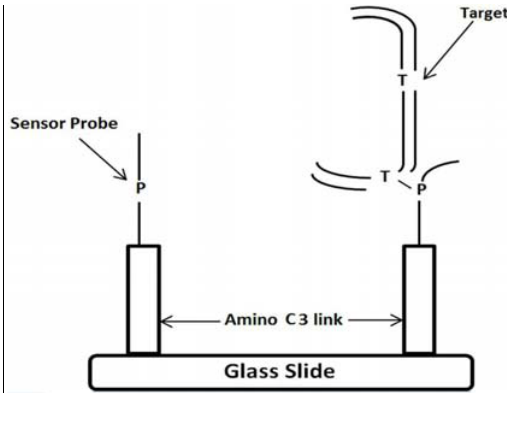
Figure 1. Schematic of the oligoarray system for the detection of A-A, EU and AF variants of LCR. On left side, the sensor probe is depicted without target, while on the right side the DNA target, being previously preannealed stabilizers with the of labeled synthetic DNA, is hybridized against the